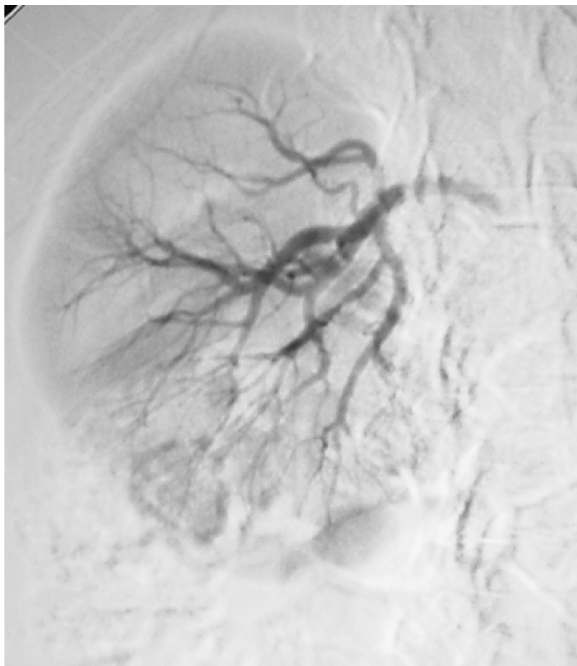
Figure 1 – Right selective renal arteriography, without identify- ing the bleeding focus.